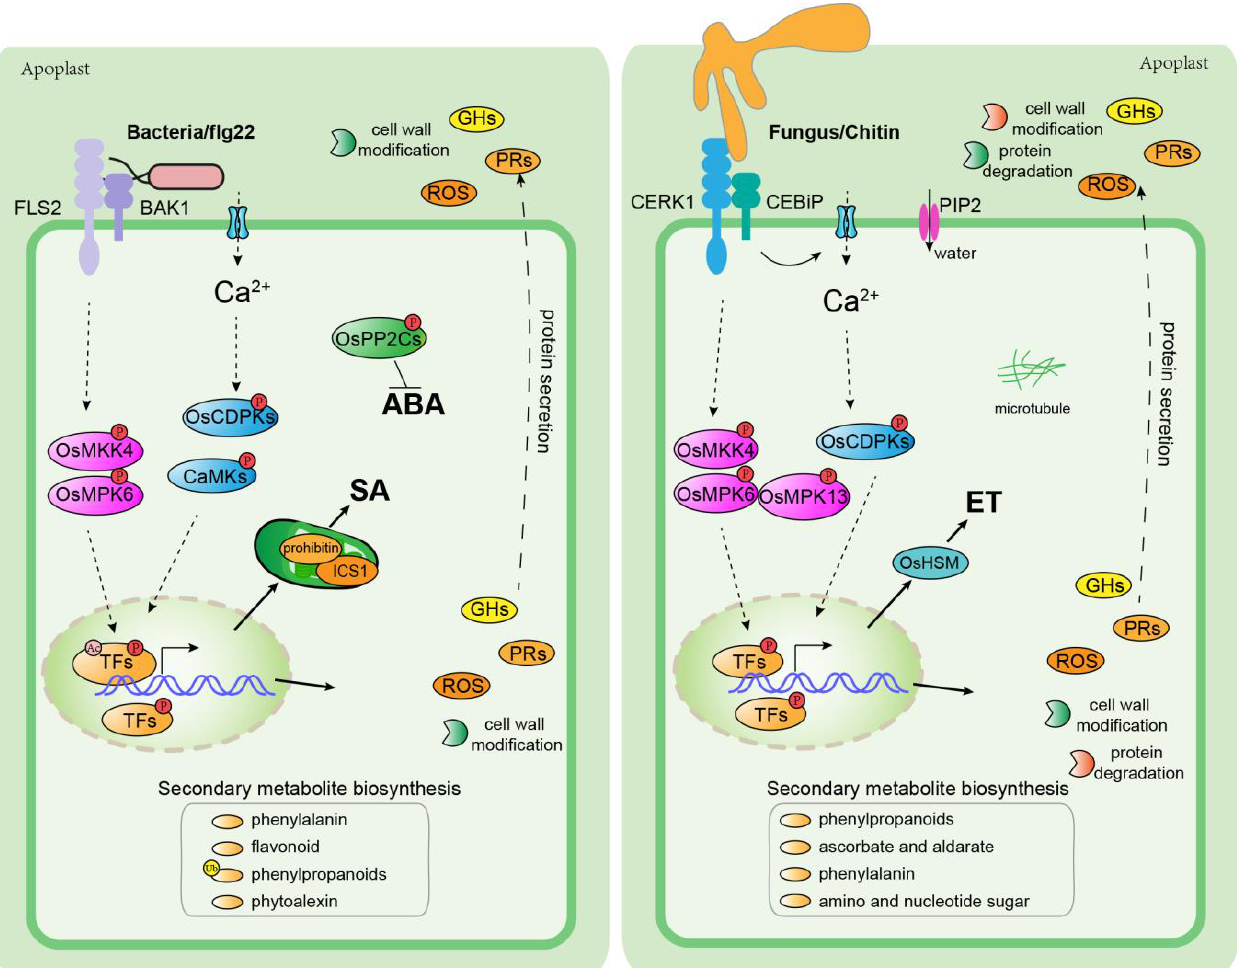
Figure 2. Proteomics-based schematic diagram of rice–microbe interactions. Sensing of bacterial and fungal pathogens by membrane-localized pattern recognition receptors leads to the phosphorylation of MAPK cascade and CDPKs in rice, which subsequently activates the downstream transcription factors, especially WRKKYs. The abundance of glycoside hydrolase family proteins (GHs), reactive-oxygen-species-related proteins (ROSs), pathogenesis-related proteins (PRs), cell-wall-modification-related proteins, and protein-degradation-related proteins are significantly increased and highly accumulated in the apoplastic region through protein secretion. Secondary metabolite biosynthesis-related proteins are also highly accumulated upon bacterial (left panel) and fungal pathogen (right panel) infection. Accumulation of SA and ET biosynthesis regulating proteins prohibitin, ICS1, and HSM were increased upon bacterial and pathogen infection, respectively. Phosphorylation of PP2Cs, a negative regulator of ABA signaling, is increased upon bacterial infection.